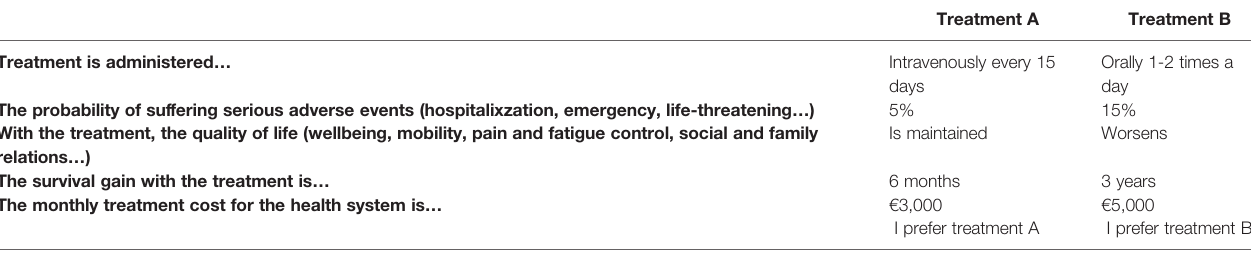
TABLE 2 | Example of a choice set presented to the study